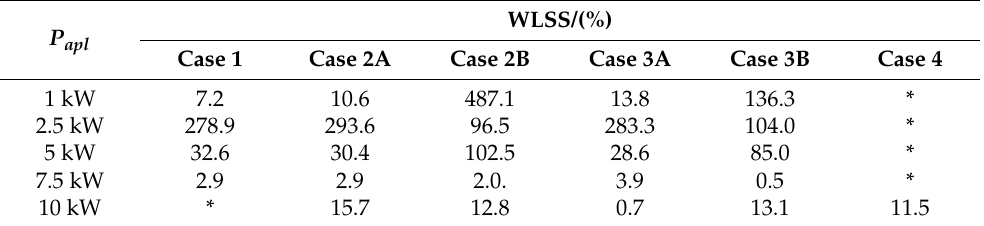
Table 3. Deviation of WLSS for power specific